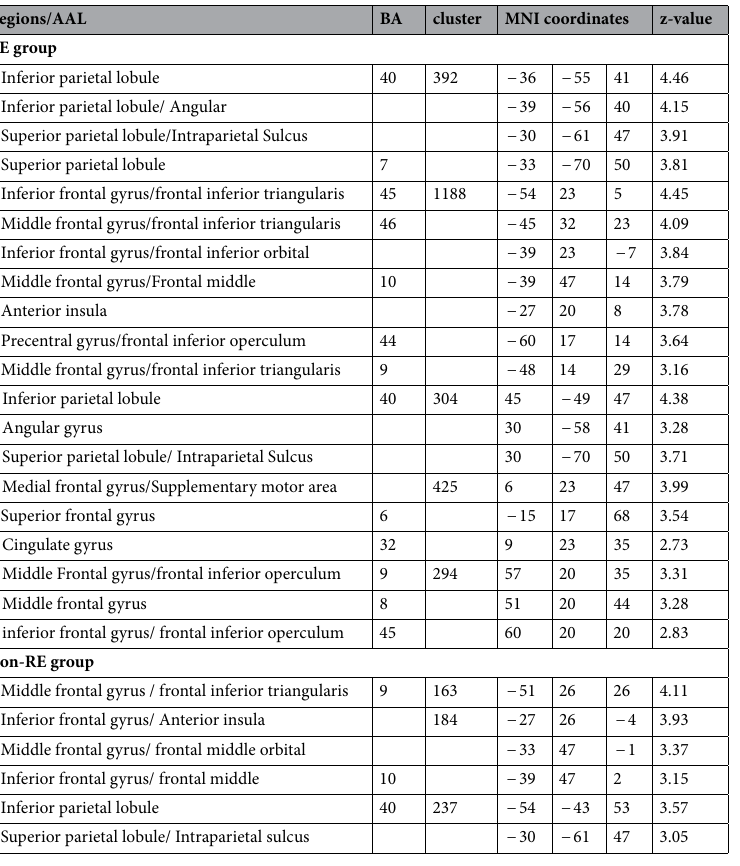
Table 3. List of brain activations as a result of RE-task. L Left, R right, BA Brodmann Area. All the analyses were corrected for multiple comparisons FWE cluster-corrected at p <